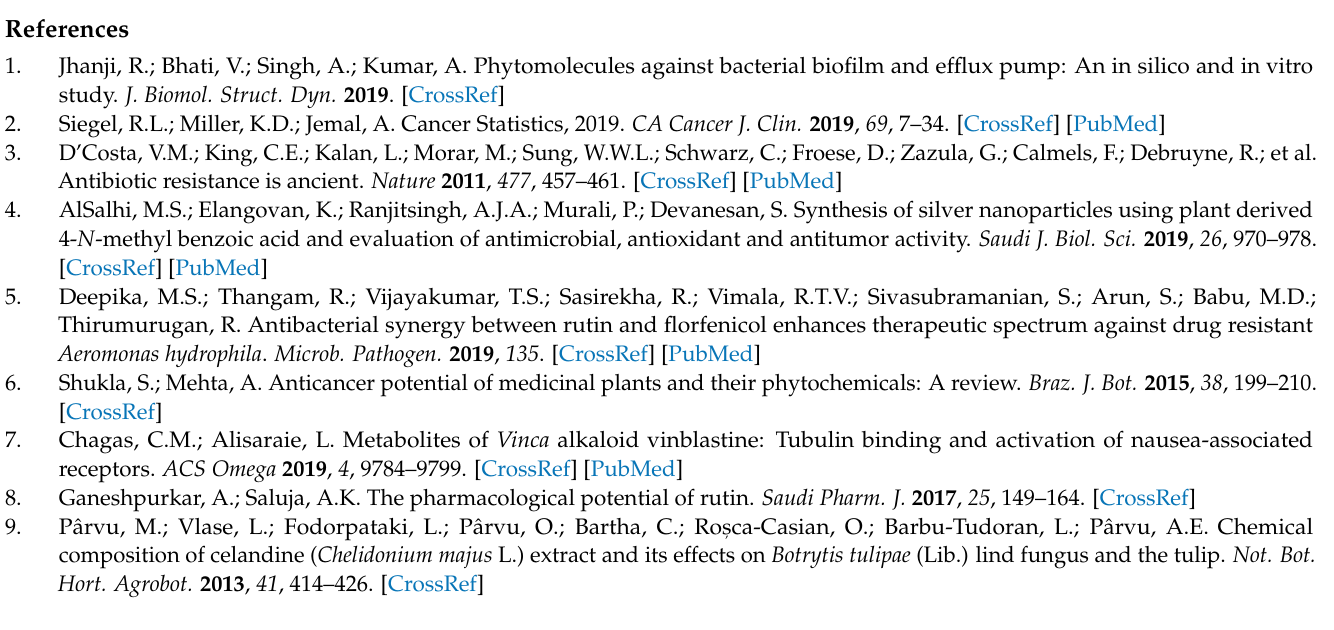
total flavonoid (A) and phenol (B) content of the analyzed extracts represented in relation to the IC 50 values observed against the HaCaT cells. The total flavonoid (C) and phenol (D) content of the analyzed extracts represented in relation to the IC 50 values observed against the A375 cells. Figure S7. LDH release expressed in relation to the total alkaloid content in HaCaT cells (A) and A375 cells (B). The LDH release expressed in relation to the total phenolic content in A375 cells (C). NO concentration expressed in relation to the total phenolic content (D) and total alkaloid content (E) in HaCaT cells. NO concentration expressed in relation to the total alkaloid content in A375 cells (F). Figure S8. TEM micrographs of the HaCaT keratinocytes treated with Vinca extracts. (A-B) untreated control, treated with (C) V. minor , (D) V. major , (E) V. major var. variegata , and (F) V. herbacea . White triangles = mitochondria, black rhombs = vesicles, N = nucleus, n = nucleolus. Table S1. Retention time, spectral features, phytochemical group, and chromatographic area (at 230 nm) for the peaks that were chemometrically analyzed. Phytochemical group (Gr.) was attributed after PCA analysis based on spectral similarities. Standards were also